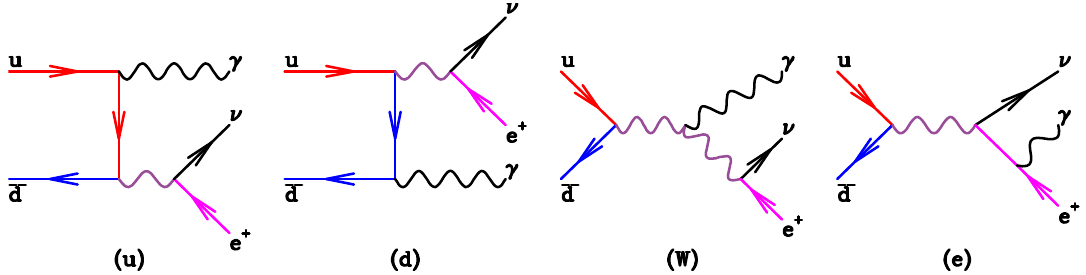
Figure 1 . Topologies of diagrams included at lowest order, shown for the specific case of u γν e e + . Note that diagrams (u) and (d) are proportional to Q u and Q d respectively, whereas diagrams, (W) and (e) are proportional to Q